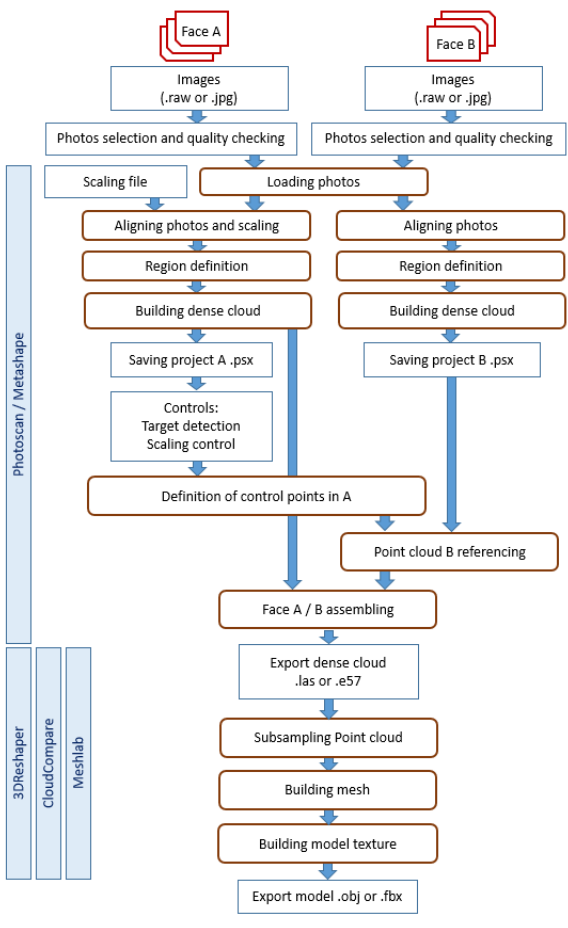
Figure 8: Workflow with assembling of two faces with one as reference and scaling unit using control points in Metashape .